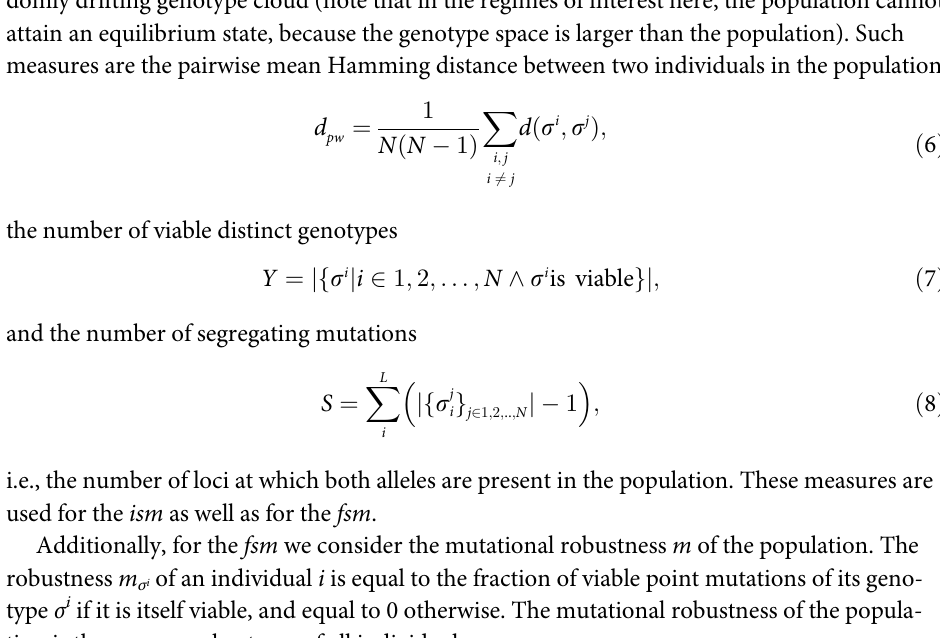
ffiffiffiffiffiffiffiffiffiffiffiffiffiffi 10 10 = U